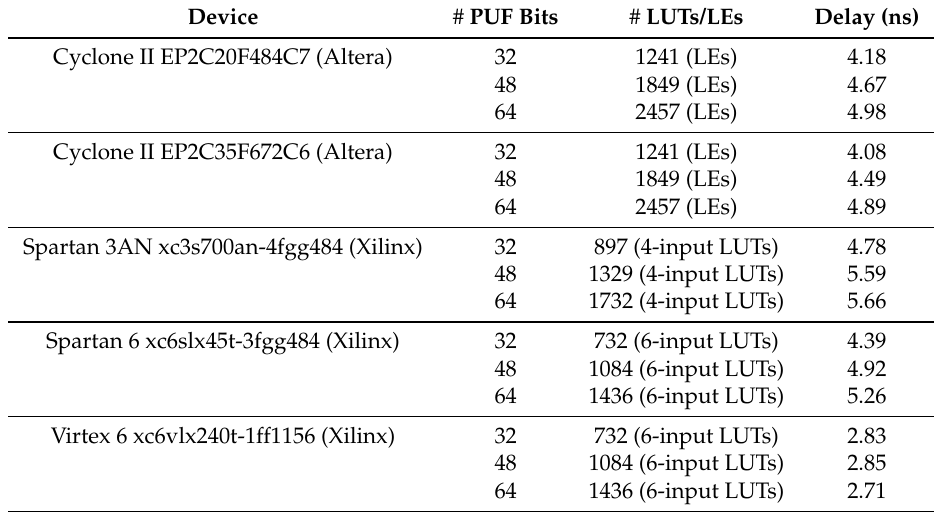
Table 1. Area and delay figures for NANDTO PUF implementation on different